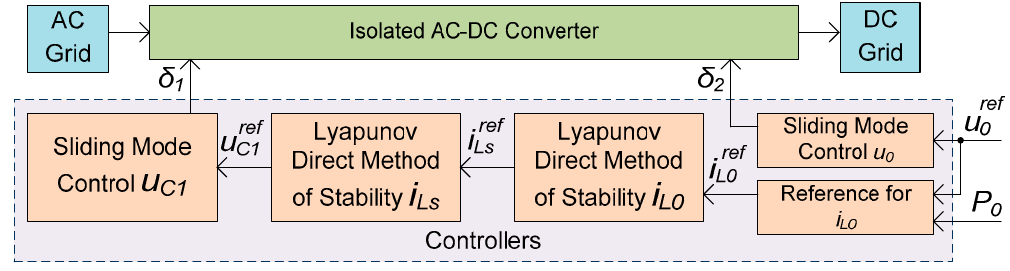
Figure 2. Simplified control block diagram proposed for the isolated AC-DC converter.